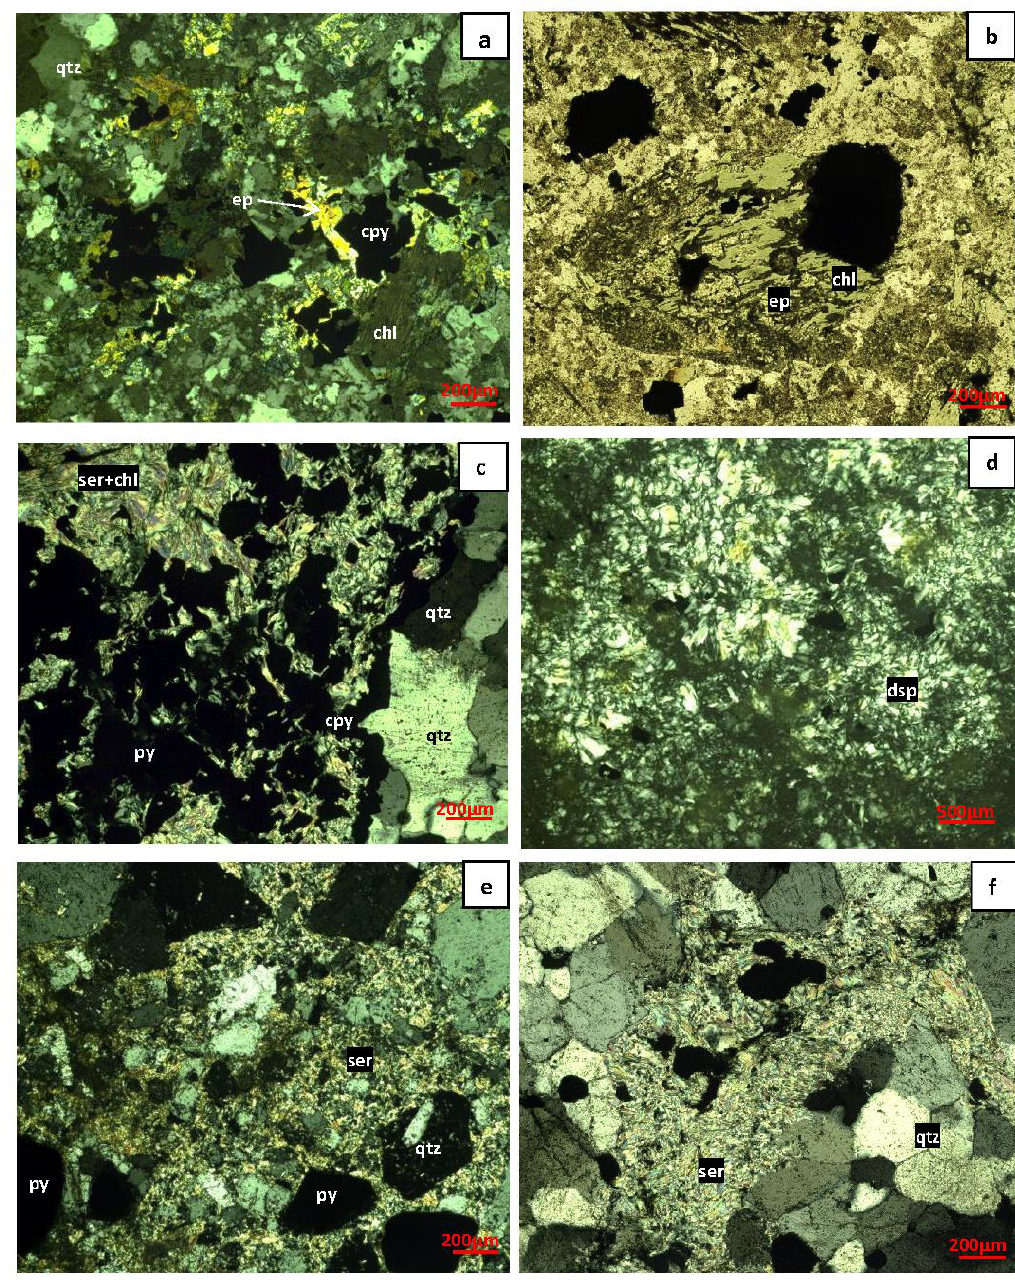
Figure 4. Images of hydrothermal alteration mineral assemblages from Assarel. ( a ) Rock with propylitic alteration: groundmass made up of quartz, albite, epidote, sericite and chlorite (sample AS6). ( b ) Mafic phenocryst (probably amphibole) substituted by chlorite and epidote in a rock with propylitic alteration (sample AS5). ( c ) Intergrowth of calcopyrite, pyrite, sericite, and chlorite in a rock with sericitic-chloritic alteration (sample AS18). ( d ) Pervasive argillic alteration with diaspore, illite, and fine-grained pyrite mineralization (sample AS14). ( e ) Disseminated pyrite in a rock with sericitic alteration (sample AS30). ( f ) Sericitic alteration, with sericite filling a vugg in a quartz-rich rock (sample AS30). Transmitted light. ( a , c – f )—crossed nicols; ( b )—parallel nicols. Abbreviations: cpy—chalcopyrite,